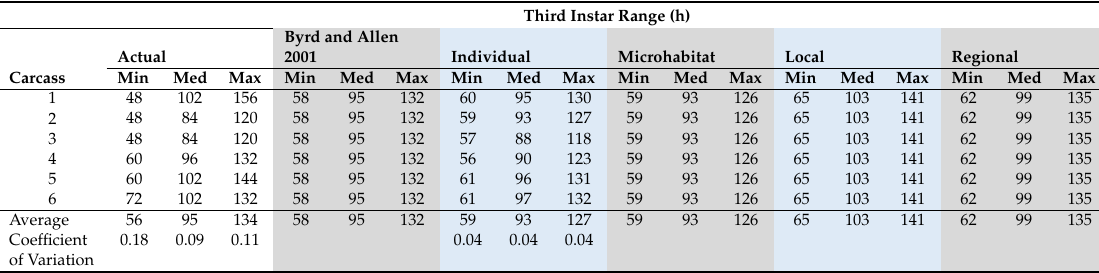
Table 4. Actual and estimated Phormia regina post-colonization intervals (PCIs) calculated using third instars and each temperature source, with a minimum developmental threshold of 6 ◦ C. Min, med, and max represent the minimum, median, and maximum ADH value for each PCI. White areas represent actual values, while gray and blue areas represent estimated values